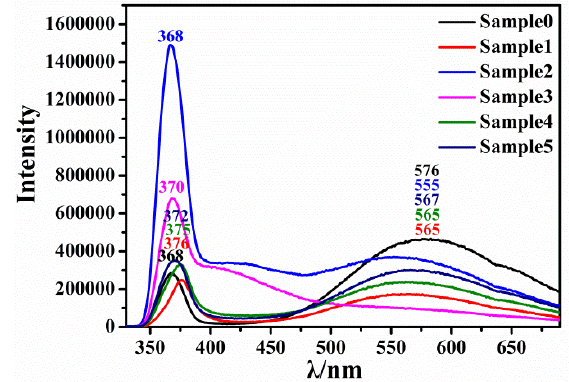
Figure 4. Photoluminescence (PL) of Zn 1-x Ni x O nanorod arrays.